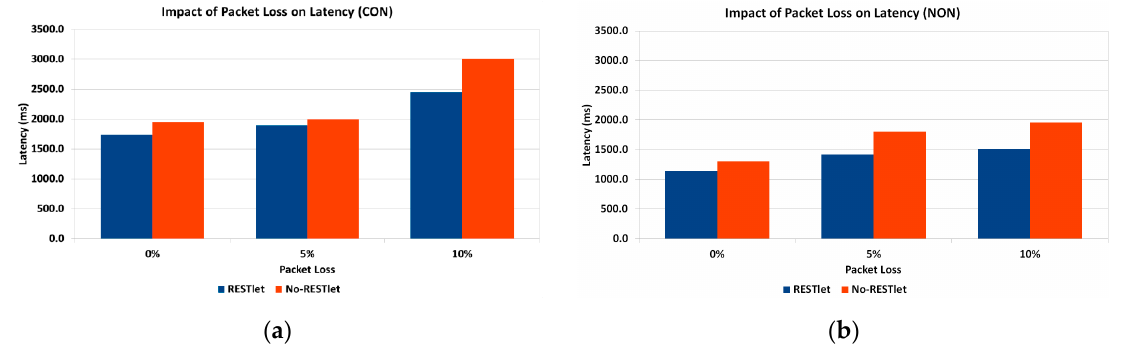
Figure 25. Impact of TX/RX Reception Ratio on Latency. ( a ) CONfirmable Communication; ( b ) NON-Confirmable Communication.